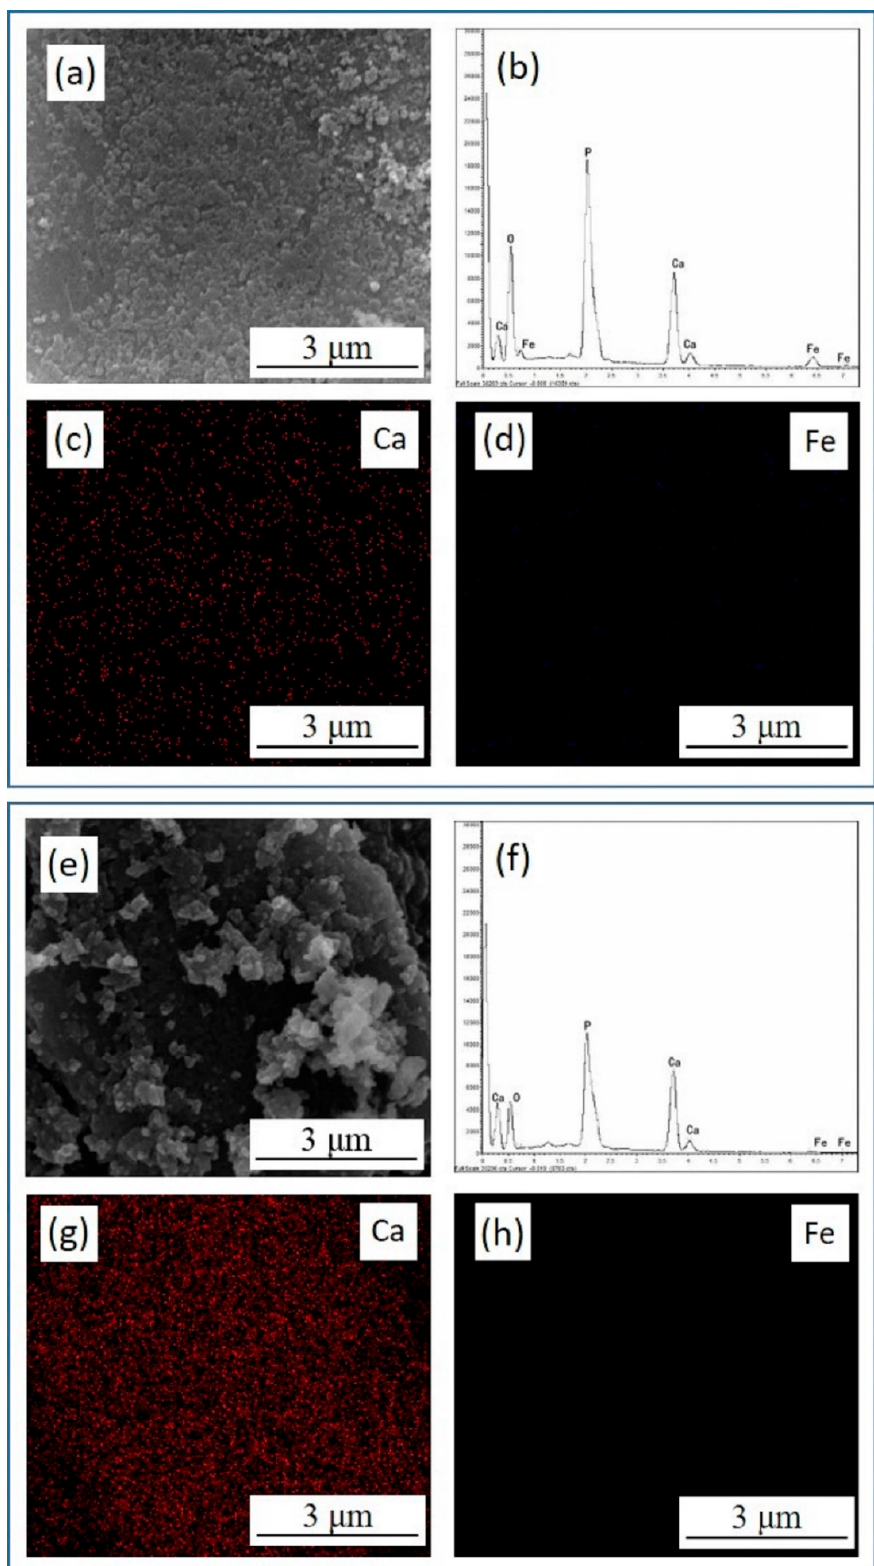
Figure 3. The EDS energy spectrum diagram, the SEM micrographs and the element distribution of the reaction solid products of Fe( Ⅲ ) transformation in presence of HAP at initial pH 2 ( a – d ) and pH 5 ( e – h ).